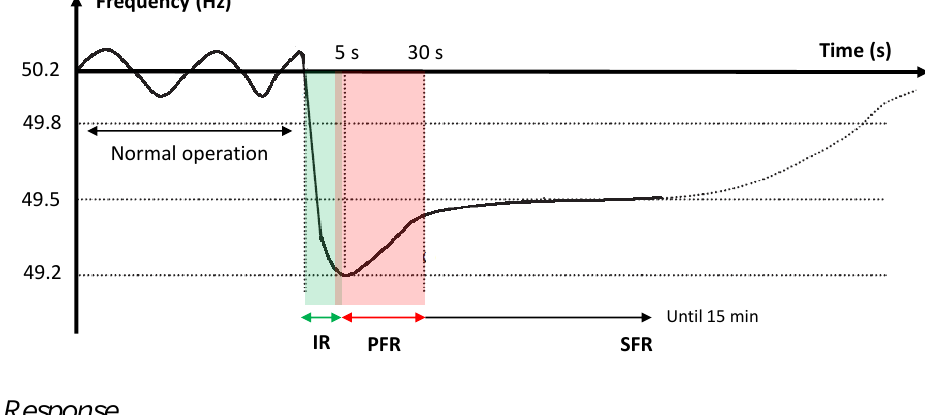
Figure 1. Time frames involved in the system frequency